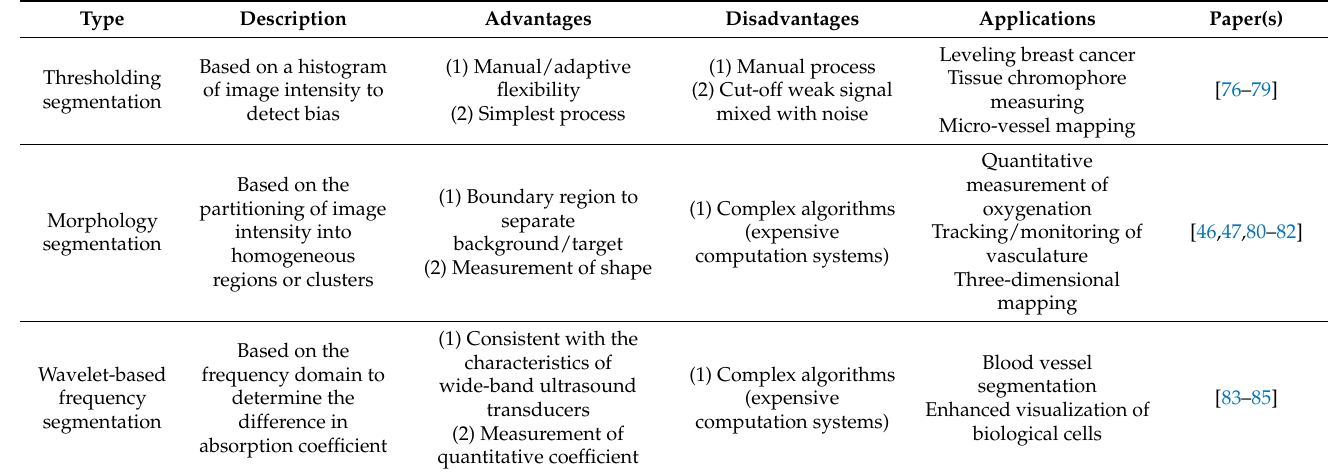
Table 1. Classic segmentation and quantification in